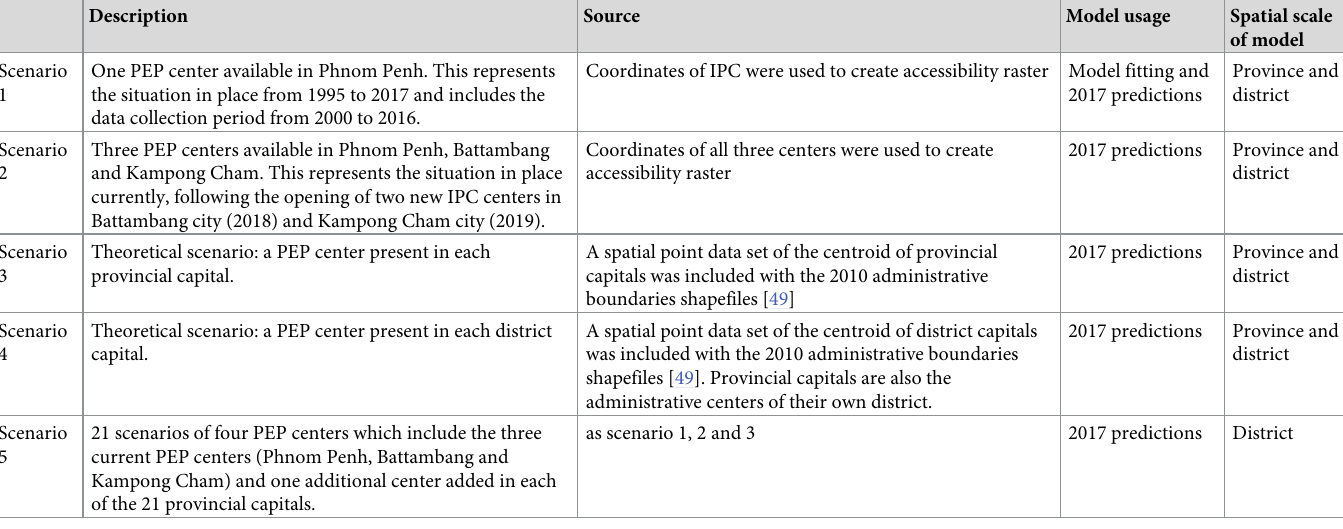
Table 1. Description of accessibility scenarios used for model fitting and predictions of future PEP patient rates and